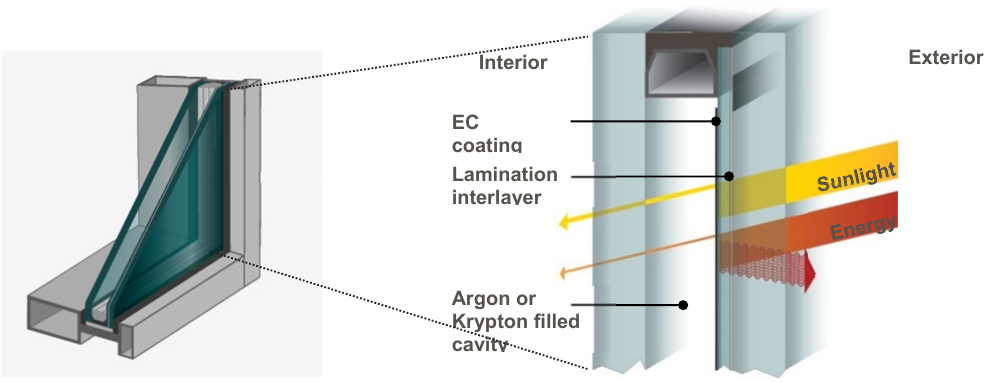
Fig. 3 All ceramic thin film electrochromic insulating glass